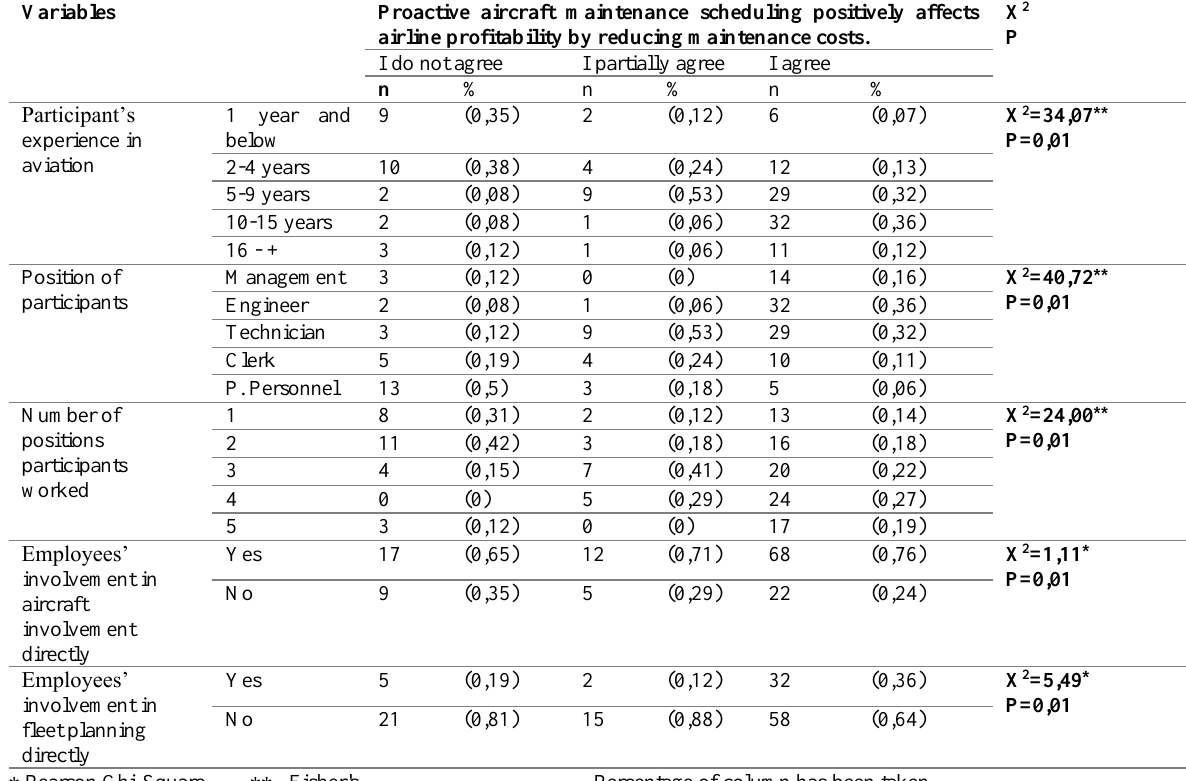
Table 10: Comparison of Answers of Participants on the Statement of “Proactive aircraft maintenance planning positively affects airline profitability by reducing maintenance costs.” with Experience-Related Variables Variables Proactive aircraft maintenance scheduling positively affects airline profitability by reducing maintenance